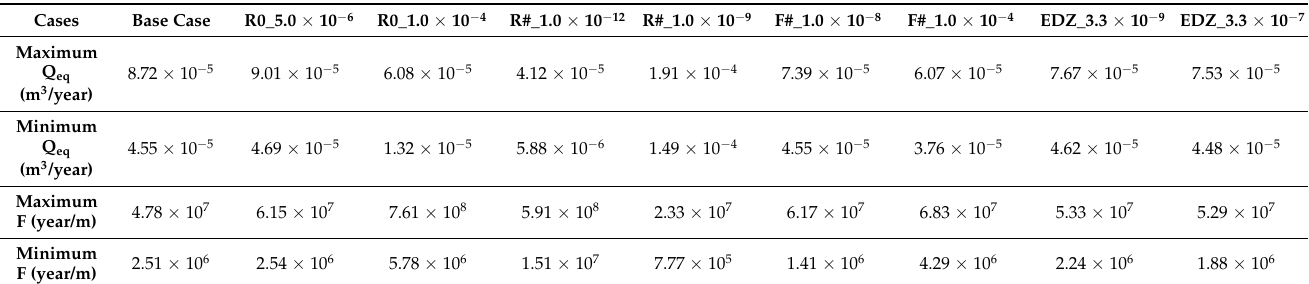
Table 4. The maximum and minimum values of Q eq and F for the base case and the sensitivity analysis cases.